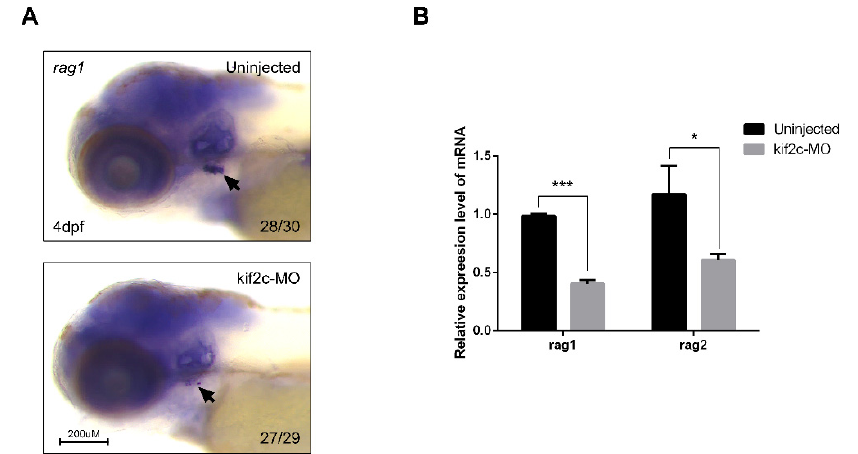
Figure 4. kif2c is linked to the development of lymphocytes in zebrafish embryos. ( A ) Whole-mount in situ hybridization of uninjected embryos and kif2c -targeting morpholino-injected embryos at 4 days post fertilization (dpf) using the lymphocyte marker rag1. Black arrows indicate the signal of rag1 at thymus. ( B ) qRT-PCR analysis of rag1 and rag2 expression in uninjected embryos and kif2c -targeting morpholino-injected embryos at 4 dpf. The expression of mRNA is normalized to that of β -actin mRNA levels (*** indicates significance at p value < 0.001, * indicates significance at p value <